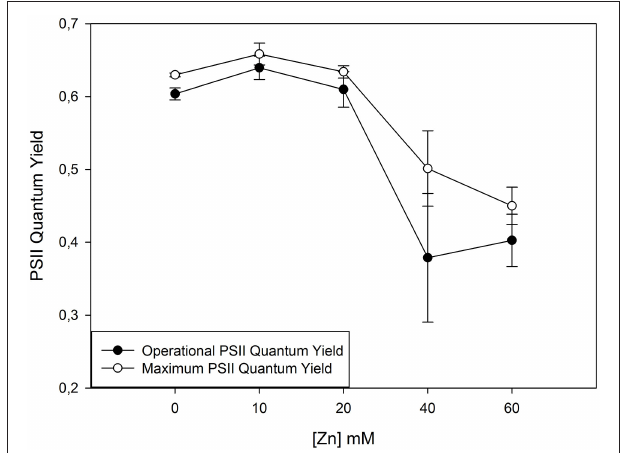
FIGURE 1 | Photosystem II (PS II) quantum efficiencies in normal light conditions (operational) and in optimum conditions (maximum) when all the PS II reaction centres are available for capturing light energy in Juncus accutus . Data is presented as average ± standard deviation. The concept of this figure is based on Santos et al.